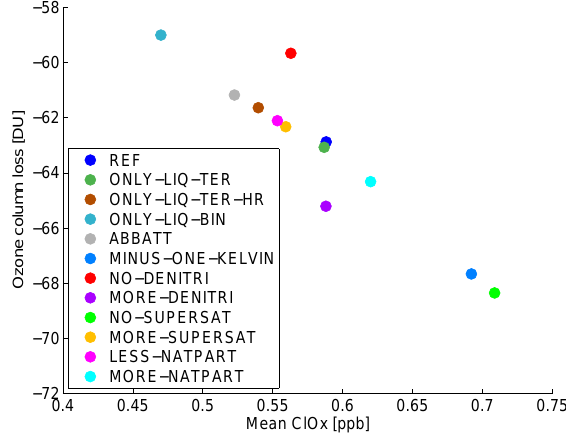
Fig. 13. Extent of chlorine activation versus column ozone loss. Av- erage of vortex mean ClO x between 15 December and 15 Febru- ary and 405 to 655K versus vortex mean column ozone loss on 1